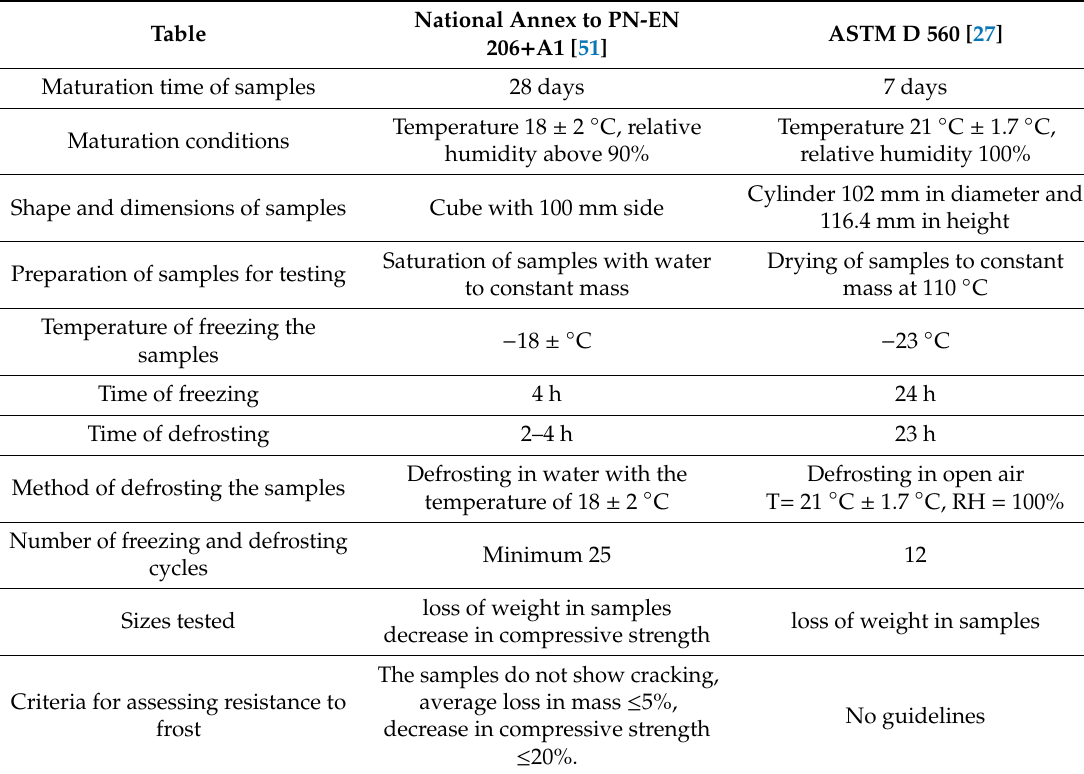
Table 4. Comparison of frost resistance assessment methods contained in ASTM D 560 and National Annex to European standard EN 206 +